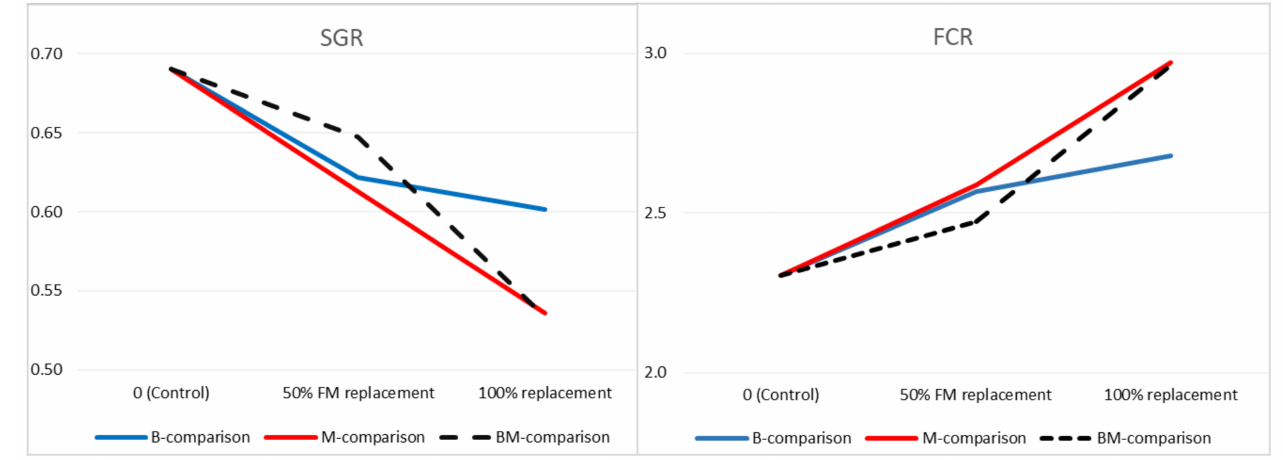
Figure 2. Variation in SGR and FCR parameters according to inclusion level of